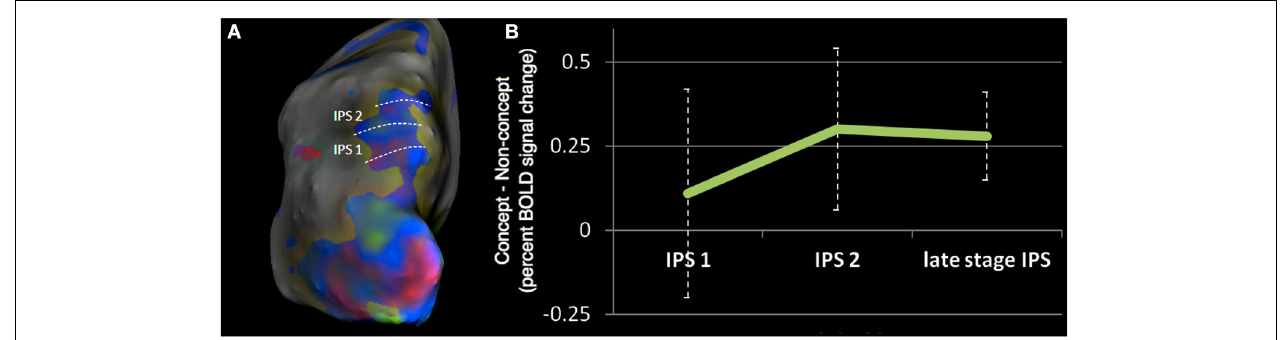
FIGURE 7 | (A) Example of retinotopically defined intraparietal sulcus (IPS) areas from a single subject, in which phase data has been projected onto the inflated cortical surface. Color indicates the visual field location of the stimulus associated with peak neural response. Green is associated with stimuli presented in the upper quadrant, blue with stimuli close to the horizontal meridian, and red with stimuli